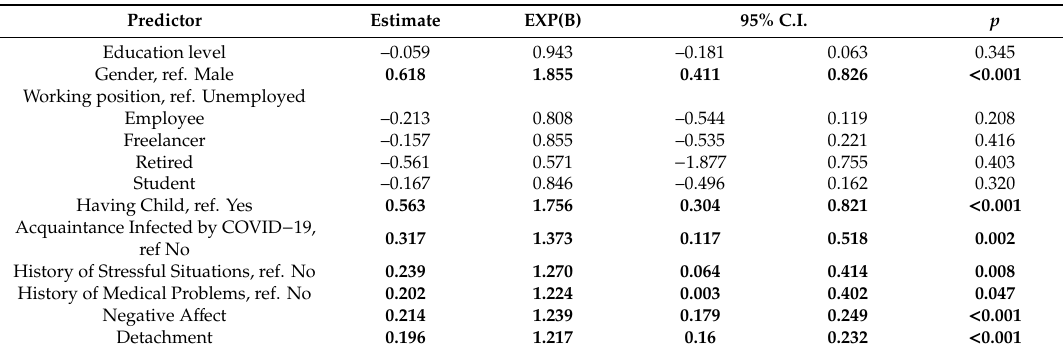
Table 4. Association between significant sociodemographic variables, personality traits, and DASS-21 depression during the COVID-19 outbreak ( n =